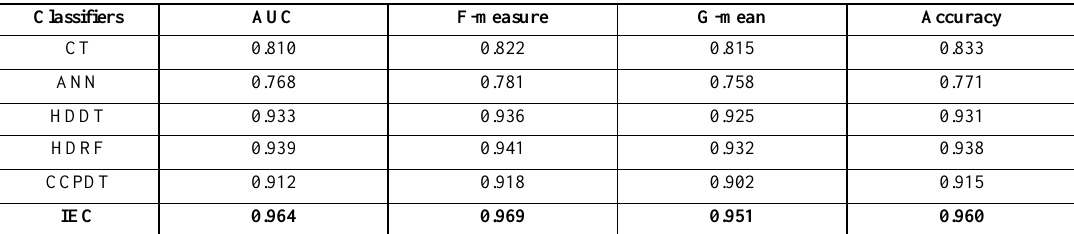
Table 2. Quantitative measure of performance for different